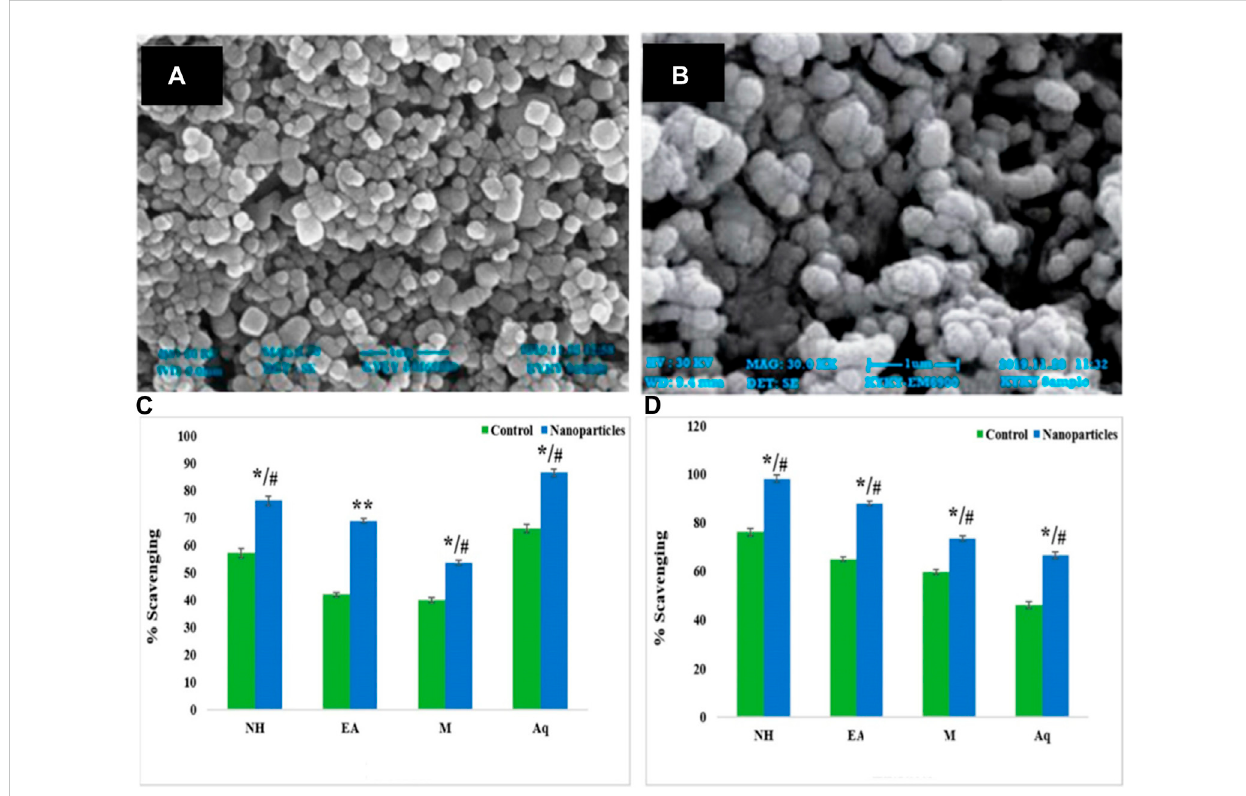
FIGURE 3 SEM images of biogenic ZnO NPs in the presence of aqueous extracts of leaves (A) and fruits (B) . The comparative DPPH scavenging antioxidant activityofcontrolandZnONPsfrom (C) leafand (D) fruitextractsof C.colocynthis .Themean±SDisexpressedas*/# p < 0.05,** p < 0.01.Modi fi edfrom (Kiani et al., 2023) CC BY